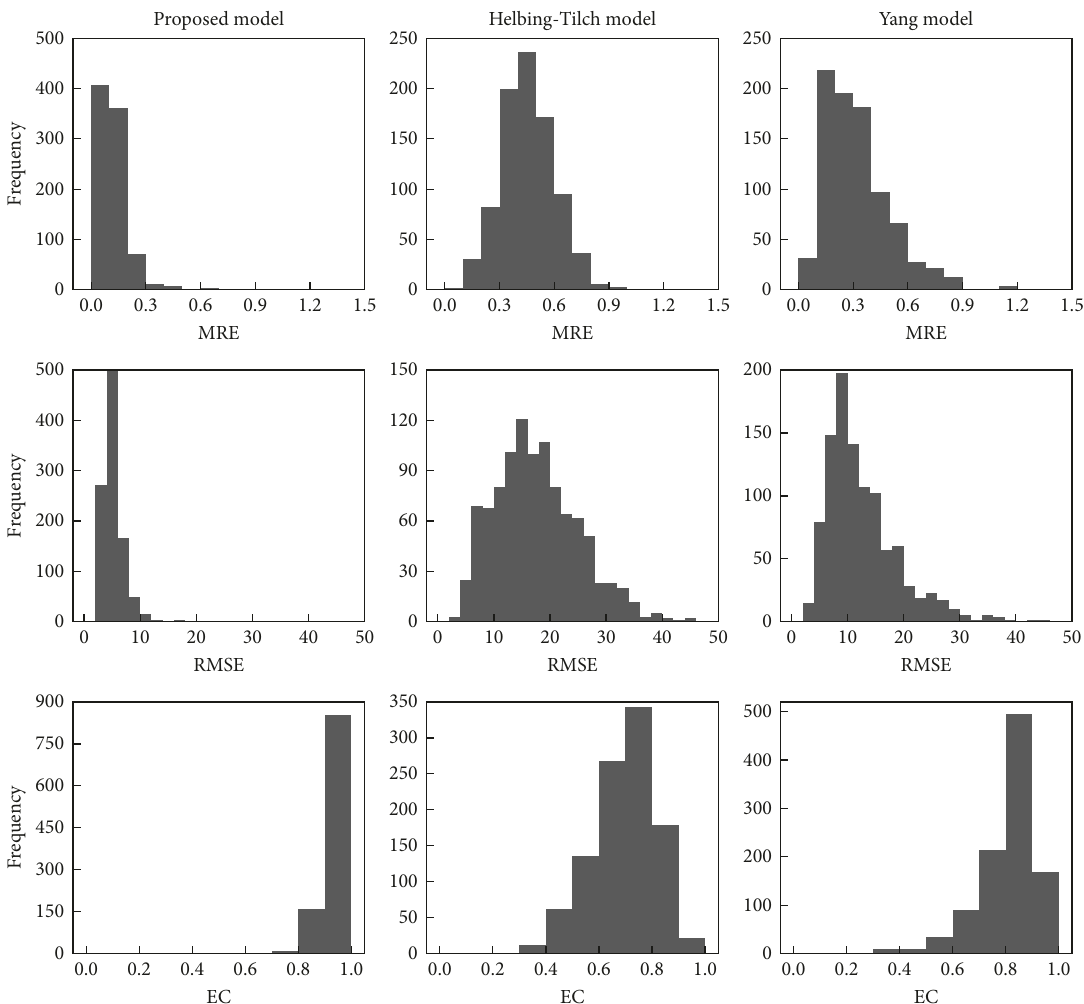
Figure 5: Distributions of MRE, RMSE, and EC values associated with car-following speed predictions by three comparison